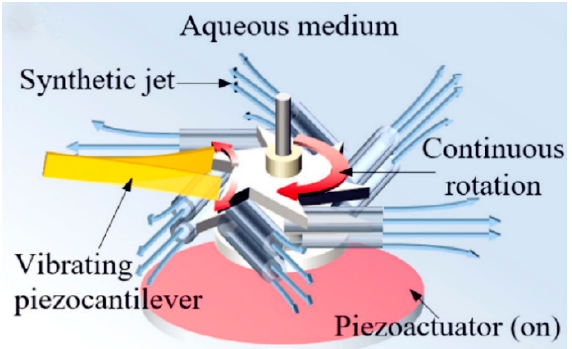
Figure 27. Components of the proposed AEH device. Reproduced with permission from [72]; published by ELSEVIER, 2018.